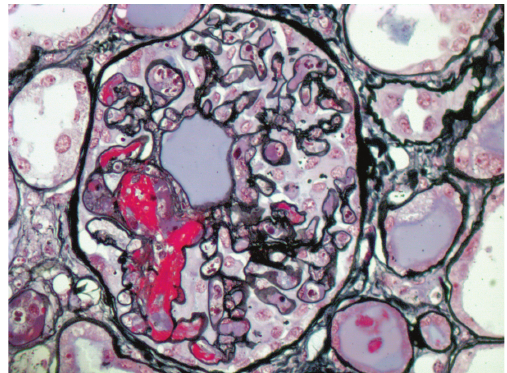
Figure 3: Glomerular capillary thrombosis in a patient with sclero- derma renal crisis. This finding is rather infrequent in scleroderma renal crisis and is more commonly observed in hemolytic uremic anemia and thrombotic thrombocytopenic purpura (Methenamine silver stain; original magnification x600).